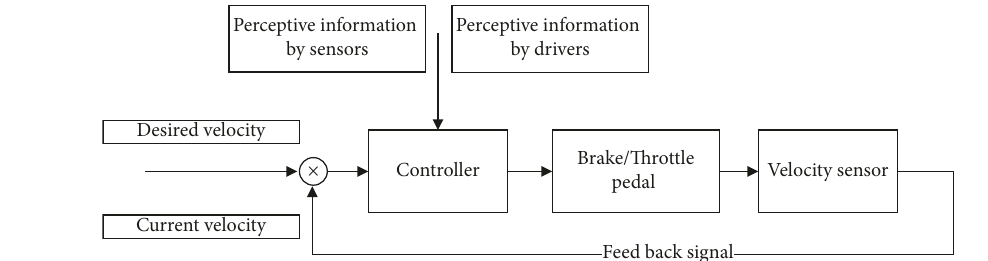
Figure 2: Basic principle of speed controller.